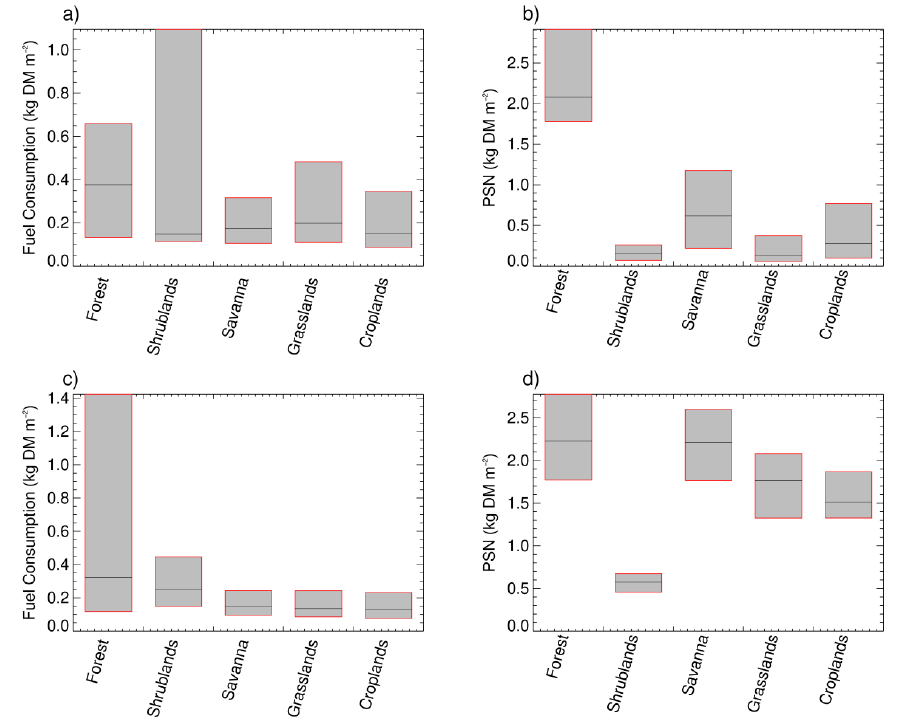
Figure 10. FRE-derived fuel consumption ( a , c ; kg DM m − 2 ) and integrated MODIS PSN ( b , d ; kg m − 2 ) estimates for five land cover types found in northern (a,b) and southern (c,d) hemisphere Africa. The upper and lower bounds of the bars are the 75th and 25th percentiles and the black horizontal line is the 50th percentile.